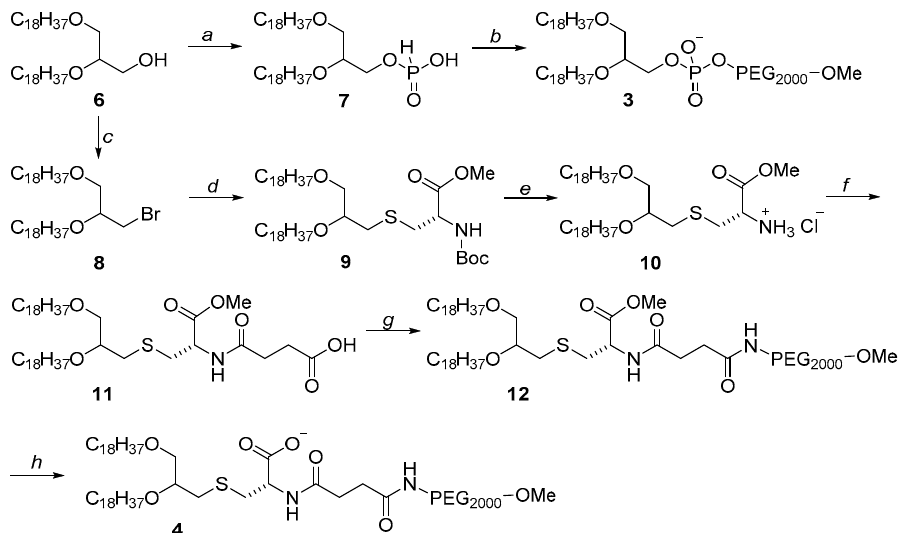
Scheme 2. Synthesis of PEG-lipids with phosphate and cysteine linkers. Reagents and conditions: